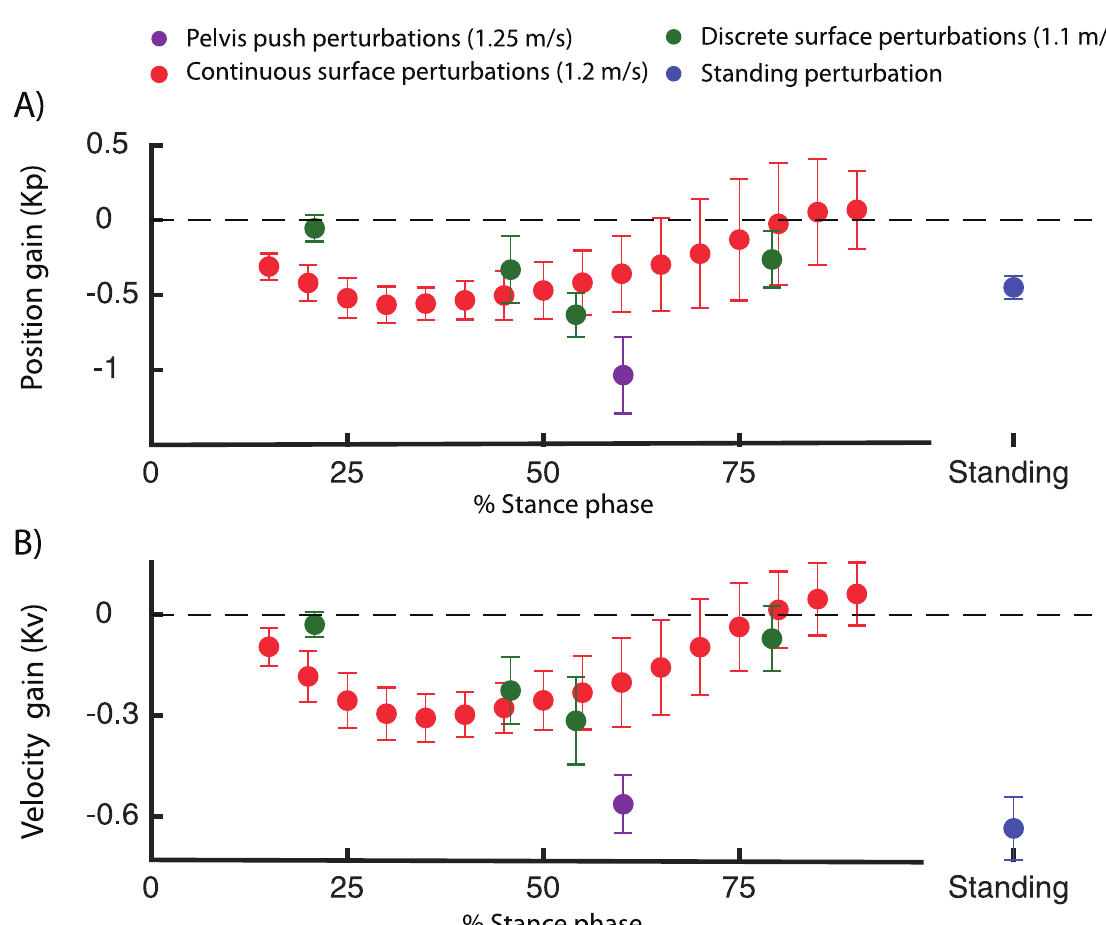
Fig 10. Position and velocity gains computed in the dataset with perturbed standing (green [26]), walking with discrete (blue [10]) and continuous(red [27]) surface perturbations and discrete pelvis push perturbations (purple [9]). The feedback gains for walking are presented as a function of the percentage of the stance phase. Note that the percentage in the stance phase represents the phase at which the feedback model was evaluated (i.e. 250 ms after perturbation onset).